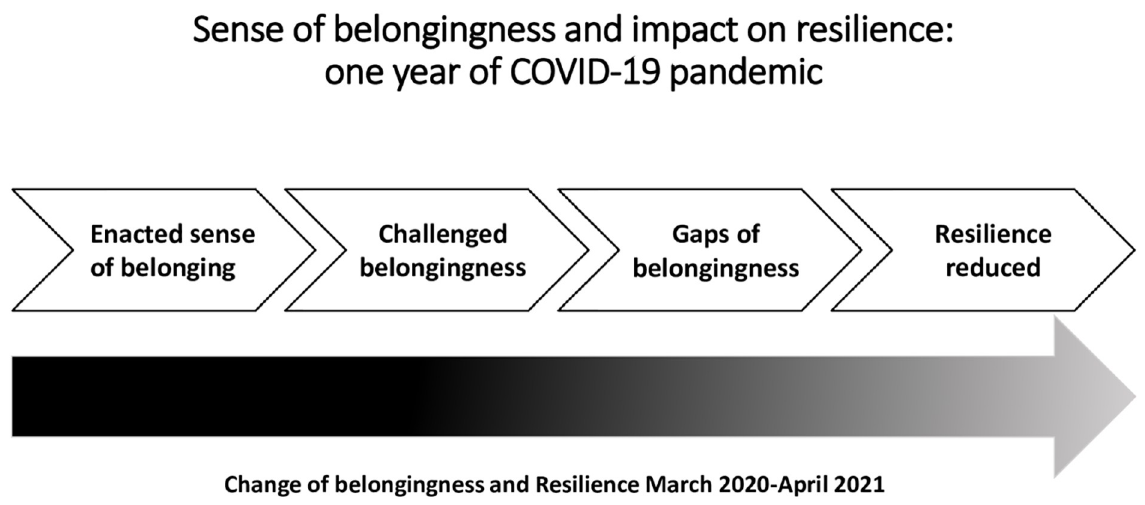
Fig 3. Challenged belongingness and its impact on resilience: First year of